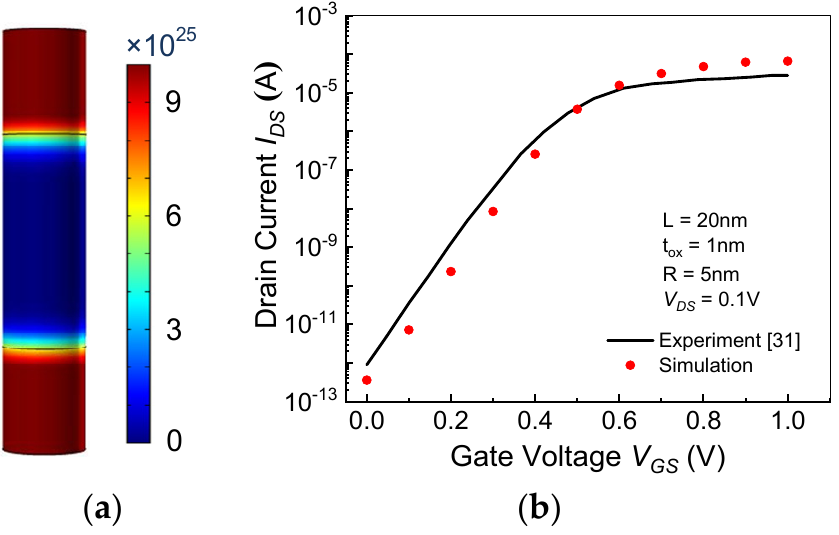
Figure 4. ( a ) The structure and doping distribution of nanowire MOSFET; ( b ) comparison of output characteristics of nanowire MOSFET with published results.